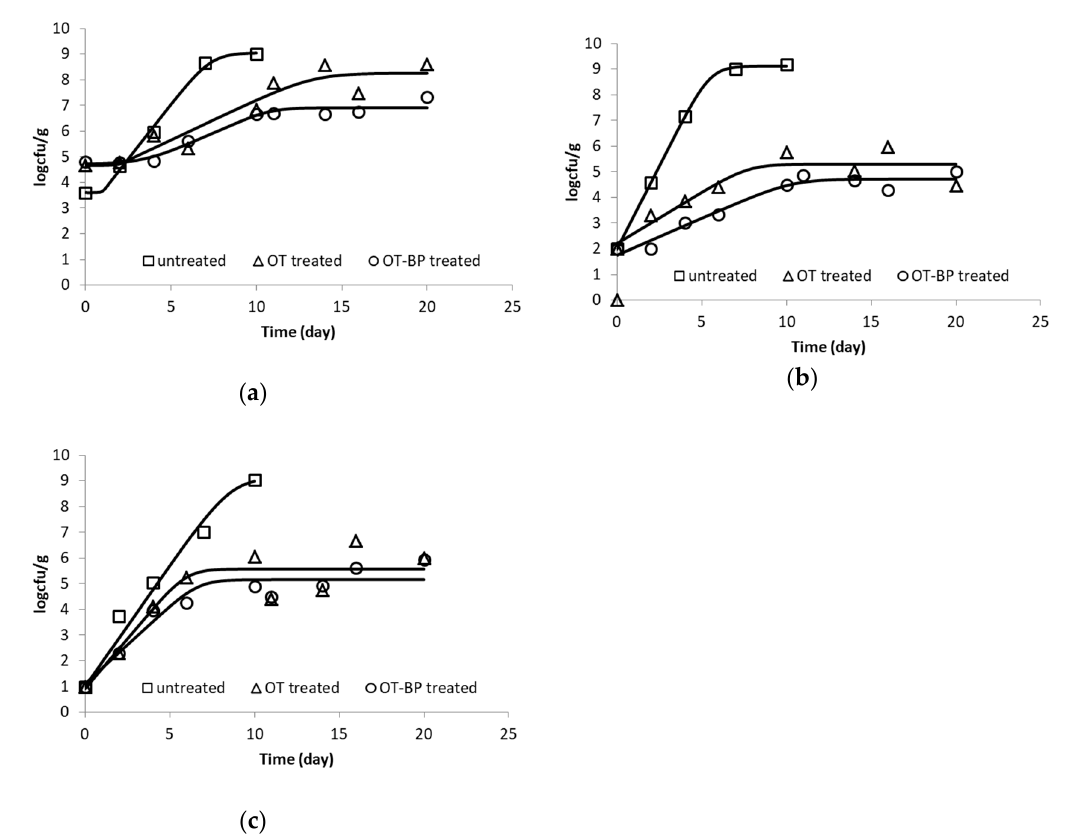
Figure 4. Microbial growth of ( a ) total viable count, ( b ) Pseudomonas spp., and ( c ) Enterobacteriaceae spp. for all samples stored at 5 °C (data points indicate the results of representative fish sample).